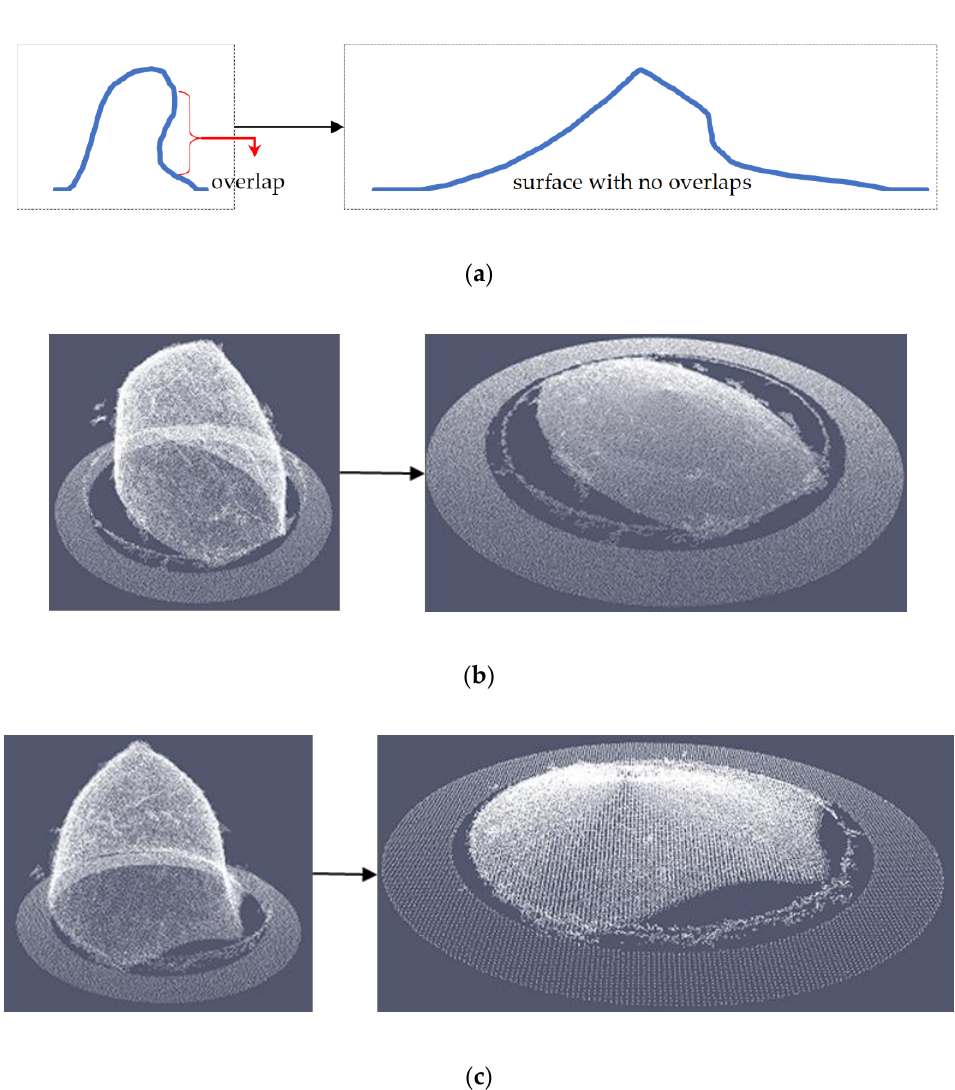
Figure 11. Linear stretching transformation: ( a ) example of stretching procedure applied to a surface with overlaps, the result is a surface without overlaps; ( b ) stretching procedure applied to a breast phantom point cloud; ( c ) stretching procedure applied to Patient 002 breast point cloud.